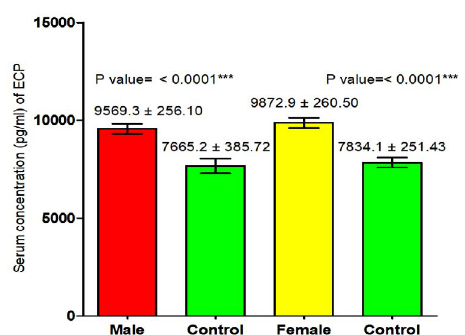
Fig. 2. Comparison between serum level of ECP in total patients infection with Sarcoptes scabiei and total control